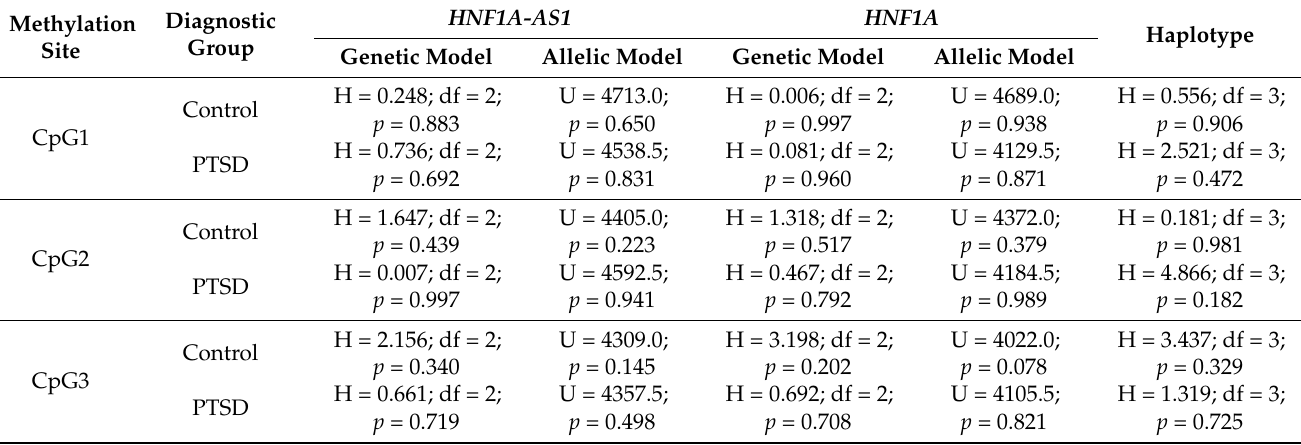
Table 2. Methylation at three CpG sites of the HNF1A gene in the patients with PTSD and the control subjects subdivided according to the HNF1A rs7953249 and rs735396 genotypes, alleles and